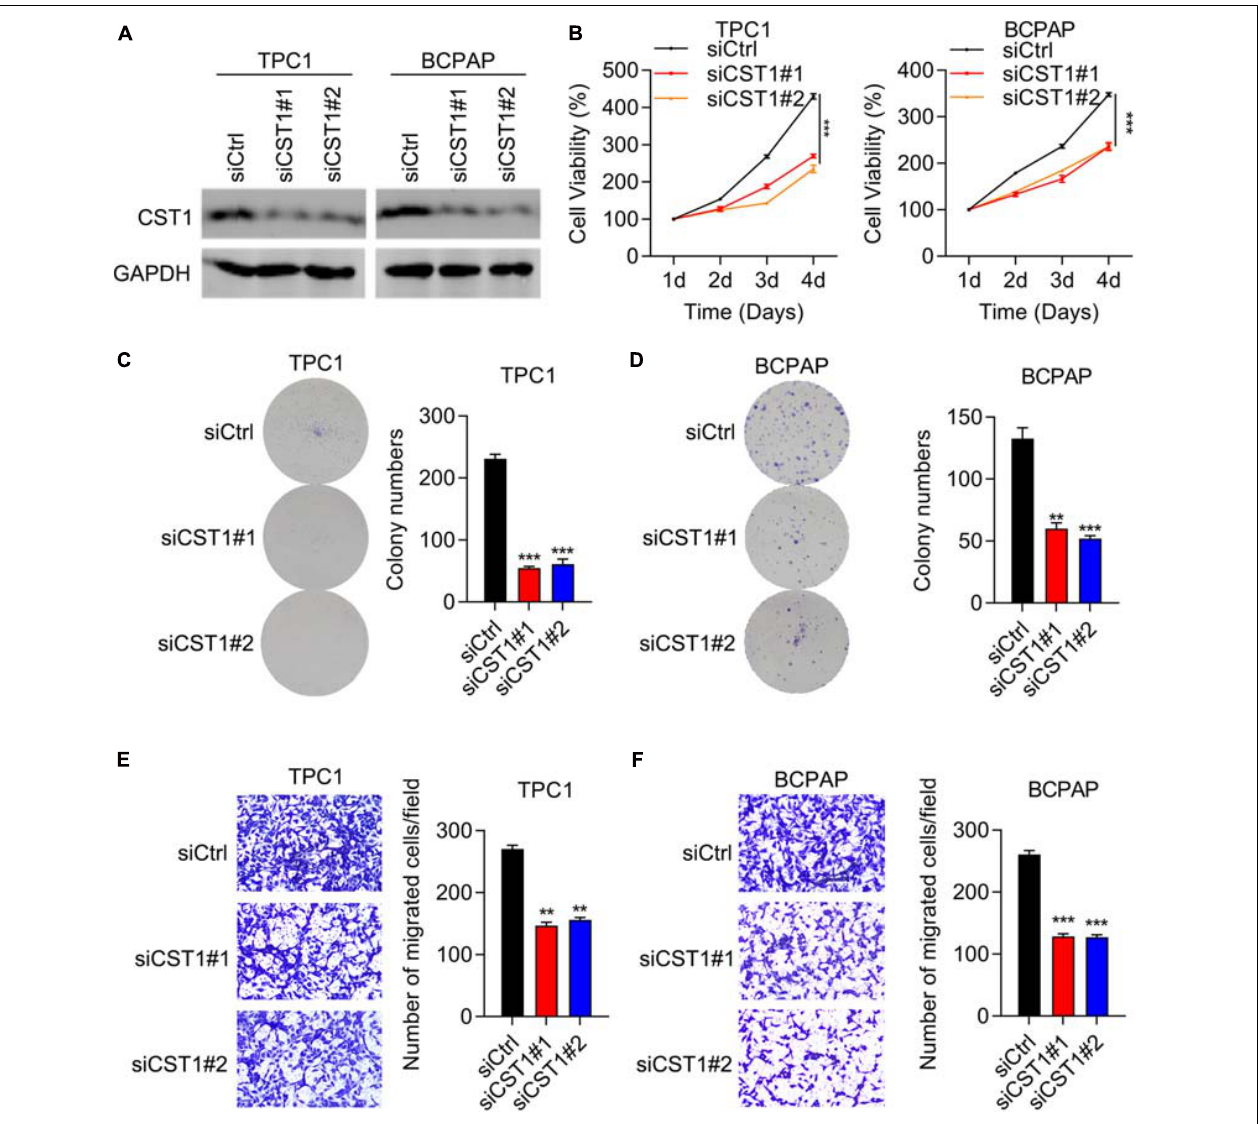
FIGURE 7 | Depletion of CST1 inhibits proliferation and invasion and promotes apoptosis. (A) Effective knockdown of CST1 in TPC1 and BCPAP cells. Western blot of TPC1 and BCPAP cells transfected with siCtrl, siCST1#1, and siCST1#2. GAPDH served as a loading control. (B) Cell viability analysis of siCtrl, siCST1#1, and siCST1#2 transfected into TPC1 and BCPAP cells using the CCK8 assay. *** P < 0.001. (C,D) Colony formation analysis of siCtrl, siCST1#1, and siCST1#2 transfected into TPC1 (C) and BCPAP (D) cells. ** P < 0.01; *** P < 0.001. (E,F) Invasion analysis of siCtrl, siCST1#1, and siCST1#2 transfected into TPC1 (E) and BCPAP (F) cells. ** P < 0.01; *** P <